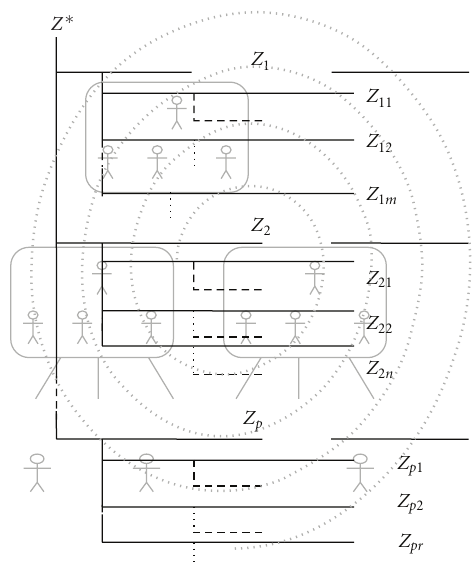
Figure 13: Task’s tree of the development process (strategy of a collective